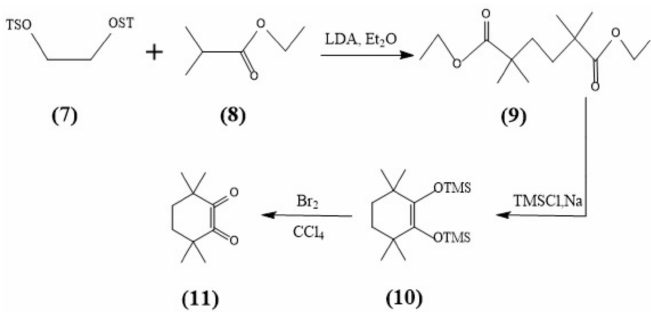
Figure 8. Synthesis of the Diketone